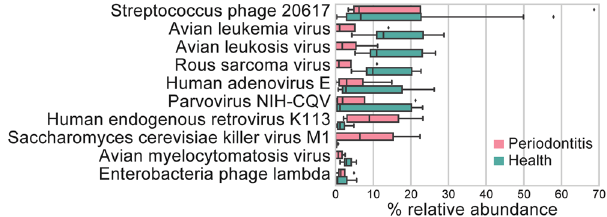
Figure 4. Virus transcripts in periodontal pockets. All virus genomes from NCBI database were used as mapping reference. Ten most abundant viruses are shown which accounted for about 80% of viral sequences. The bottom and top of the box show the first and third quartiles, the line inside the box indicates the median, and the ends of the whiskers represent the minimum and maximum, the dots on the outside of the whiskers represent outliers.